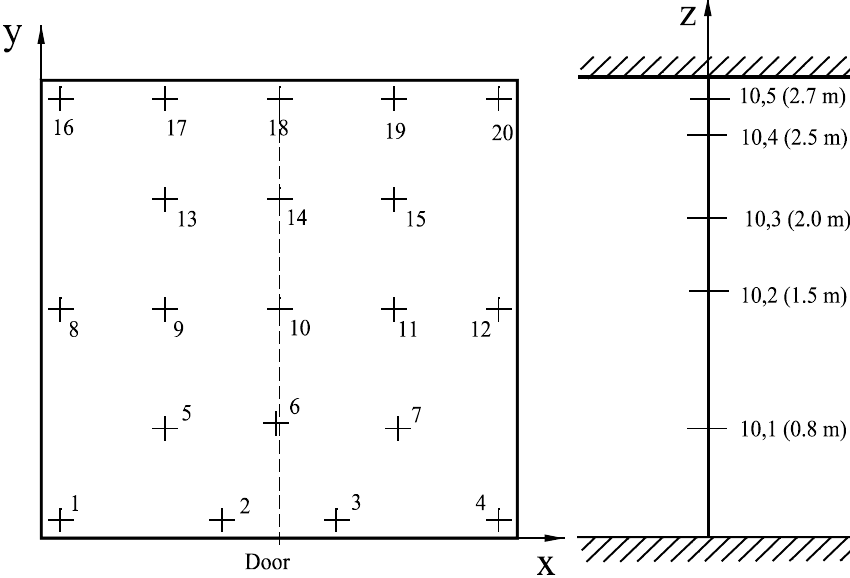
Fig. 4. The arrangement of thermocouples in horizontal and vertical planes (example for tree no. 10)